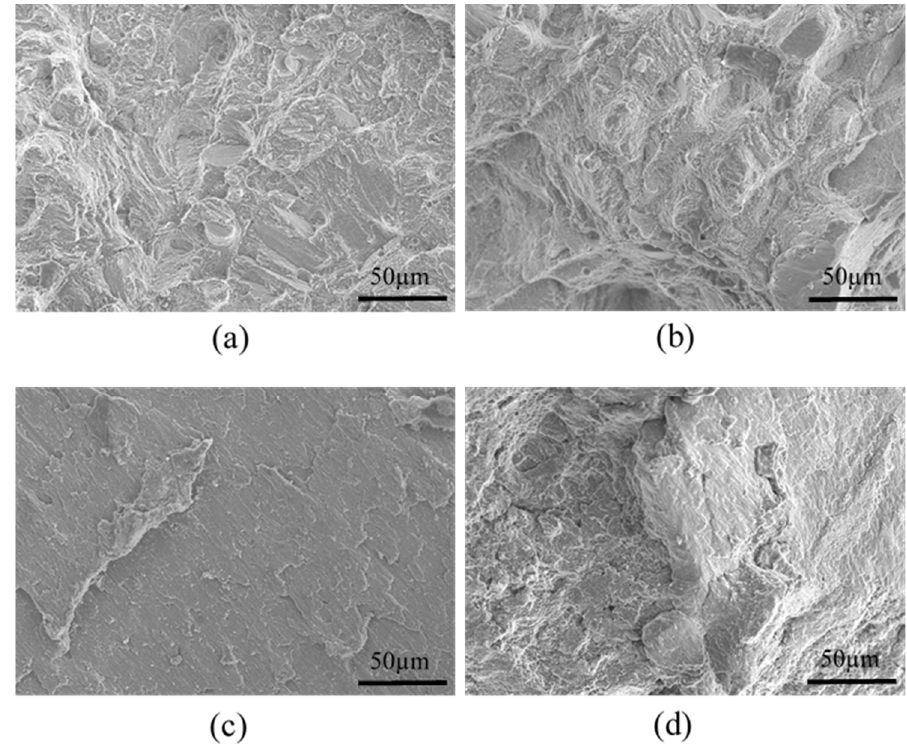
Figure 10. Macrostructure of the fatigue fracture of the Al-Ni-Cu alloy before and after solution treatment (load: 17 kg): ( a ) As-printed and ( b ) 530 °C for 1 h and 175 °C for 6 h.